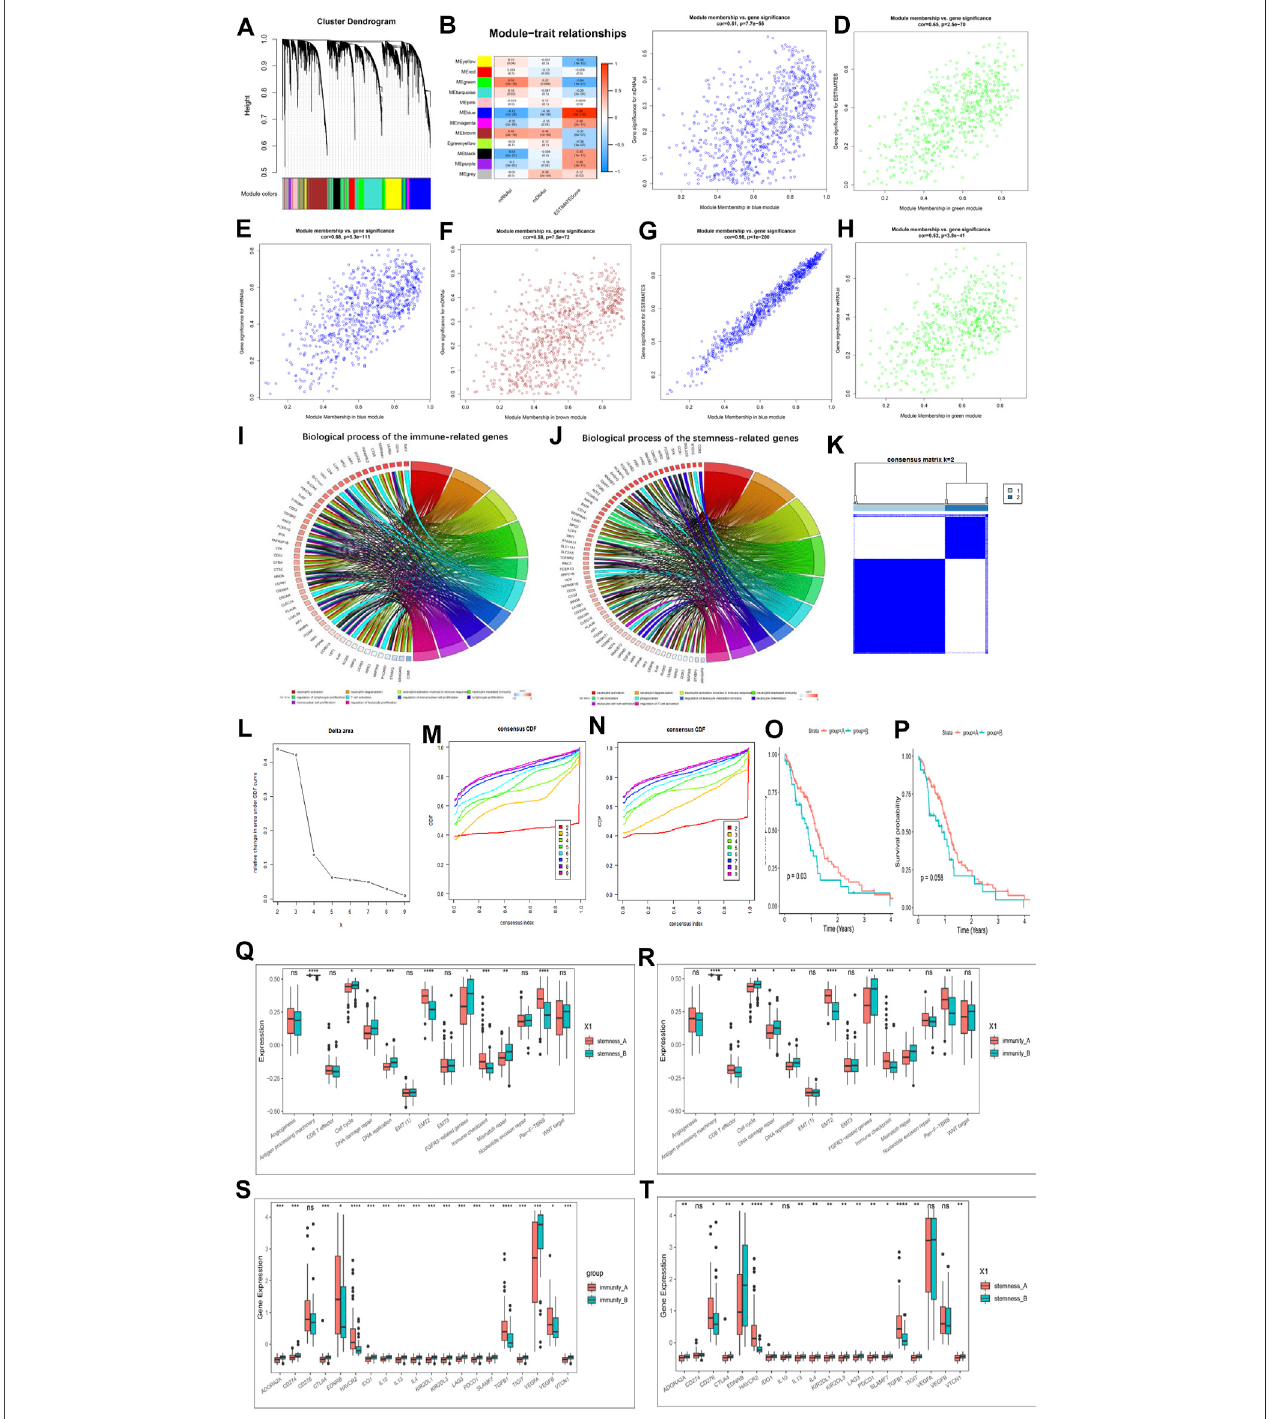
FIGURE5| Hubgenes ’ functionalannotationandcharacteristicsofpotentialtraitsinm6A-relatedphenotypes. (A) Hierarchicalclusteringdendrogramsofidenti fi ed co-expressed genes in modules. The branches of the cluster dendrogram correspond to the different gene modules. Each leaf on the cluster dendrogram corresponds to a gene Each colored row represents a color-coded module. A total of 12 merged modules were identi fi ed. (B) Correlations between the gene modules and clinical traits. The correlation coef fi cient in each cell represented the correlation between the gene module and the clinical traits, which decreased in size from red to blue. (C – H) Scatter plot of module eigengenes in the blue module with mDNAsi (C) , a green module with ESTIMATE score (D) , a blue module with mRNAsi (E) , a brown module with mDNAsi (F) , a blue module with ESTIMATE score (G) , a green module with mRNAsi (H) . Cor is the coef fi cient indices and p is Pearson ’ s correlation. (I) GO